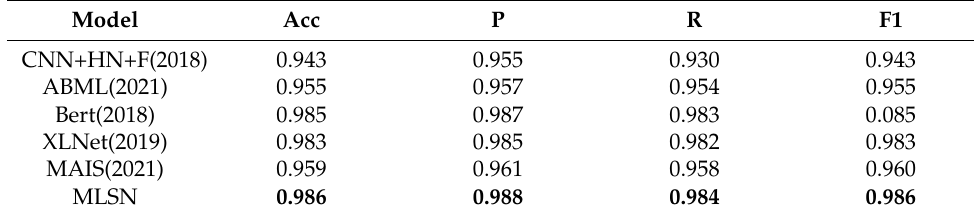
Table 3. Evaluation results of each model on 200k-Oneliners dataset.